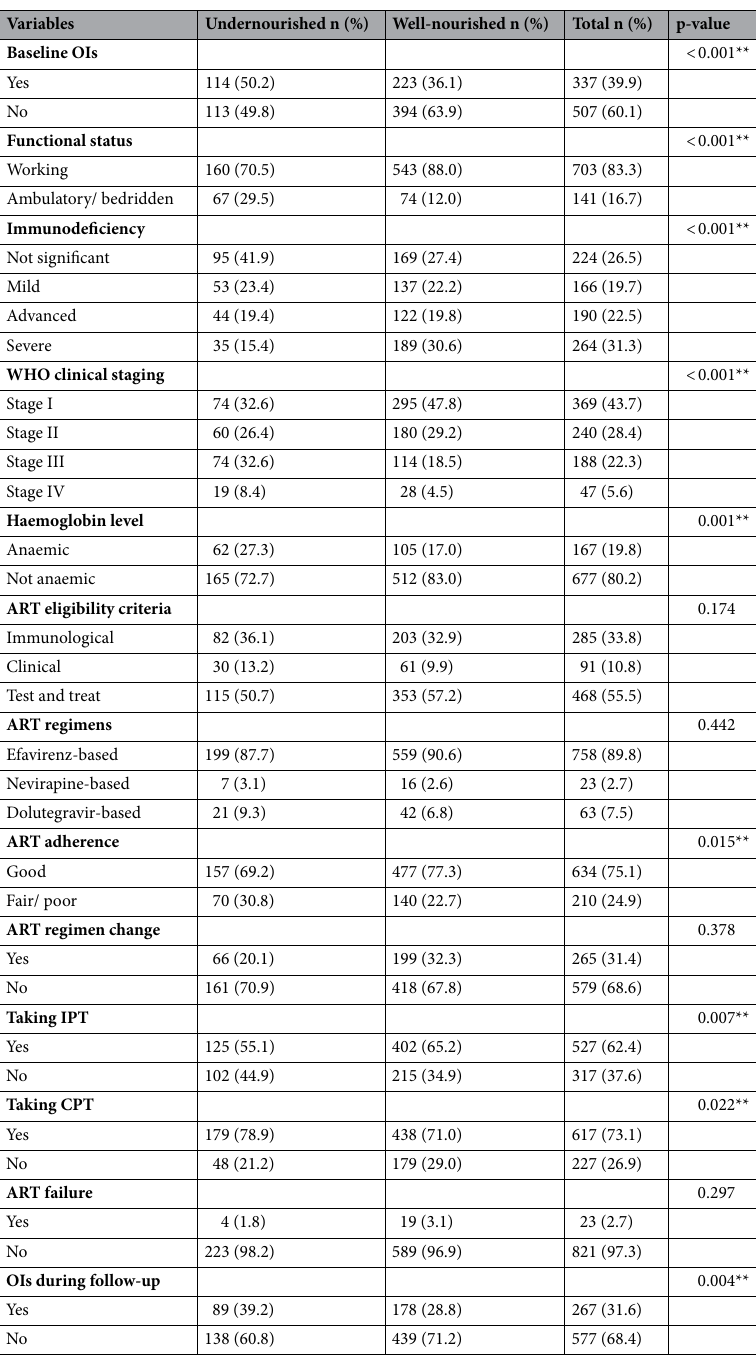
Table 2. Clinical, immunological, and medication-related characteristics of undernourished and well- nourished participants at Debre-Markos Comprehensive Specialized Hospital, Northwest Ethiopia (n =